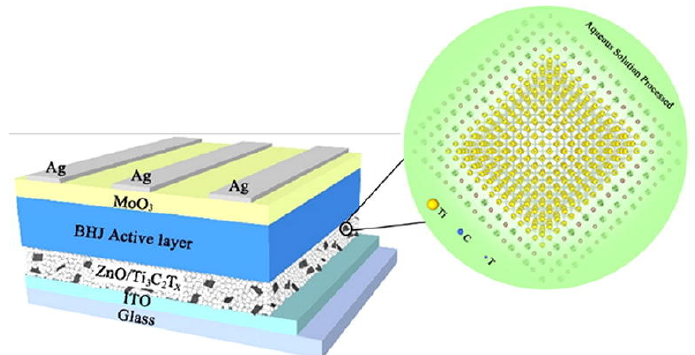
Figure 3. Schematic representation of the IPSCs configuration. Reprinted with permission from ref.